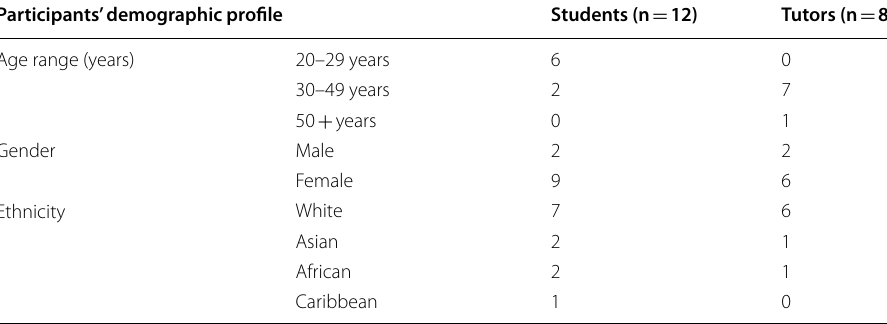
Table 1 Demographic profile of